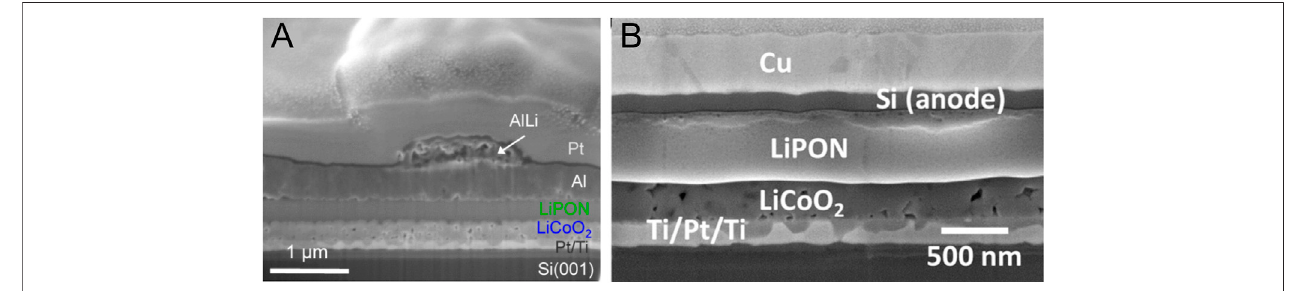
FIGURE 3 | (A) Cross-sectional SEM image of Al electrode after 10 charging cycles, tilt (cid:2) 45 ° . The Pt layer is added uniquely to protect the surface of the battery duringtheionmillingprocessandisnotanactivelayerofthedevice.ReprintedwithpermissionfromGongetal.(2015). © 2015ACS (B) Focusedionbeamcrosssection of an ASTB. Reprinted with permission from Talin et al. (2016). © 2016